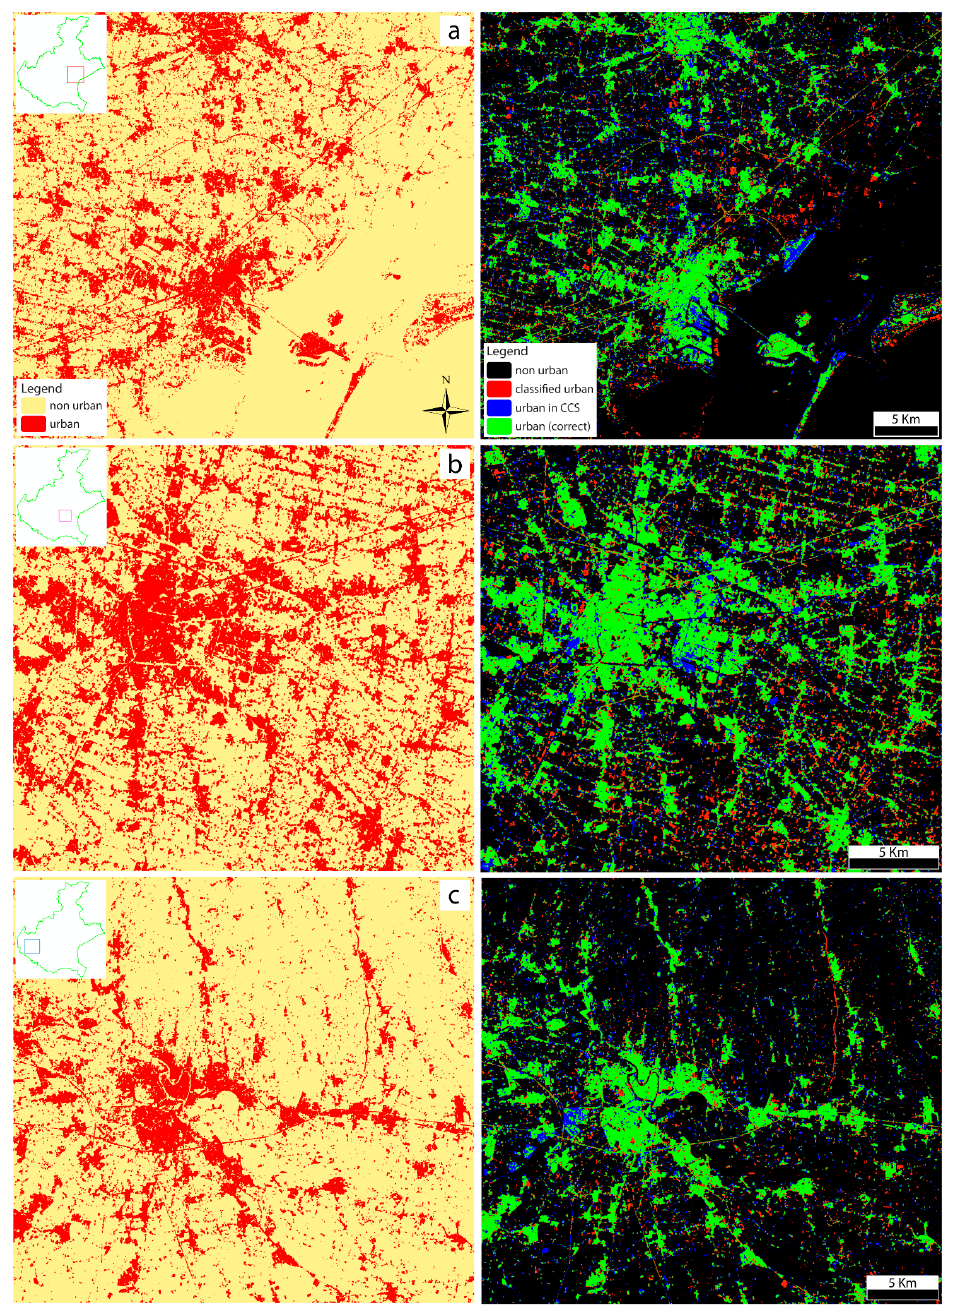
Figure 13. K-means unsupervised classification and related accuracy assessments (using CCS as reference map) performed on the same test areas previously analyzed with supervised classification algorithms. ( a ) Venice study area. ( b ) Padova study area. ( c ) Verona study area. For all the study areas, the scale indicated in the accuracy image on the right is equivalent to the relative classification image on the left, therefore we did not replicate it for better visibility.